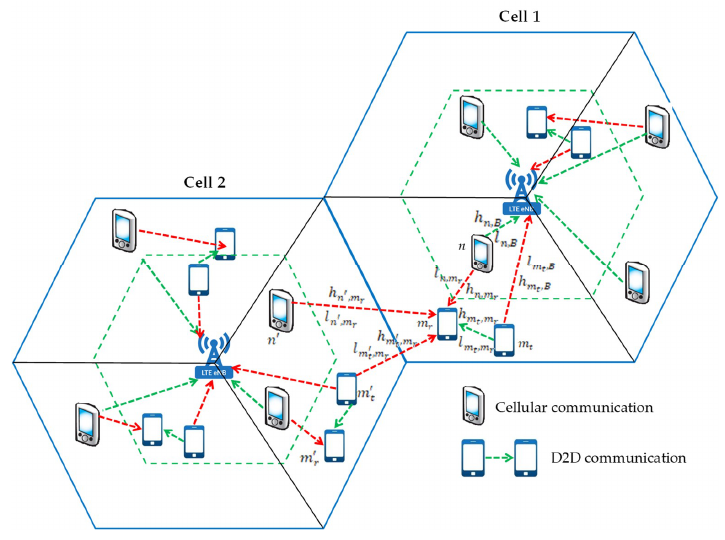
Figure 3. Demonstration of the interference between two neighboring cells, when a D2D communications is overlapped on a cellular resource.